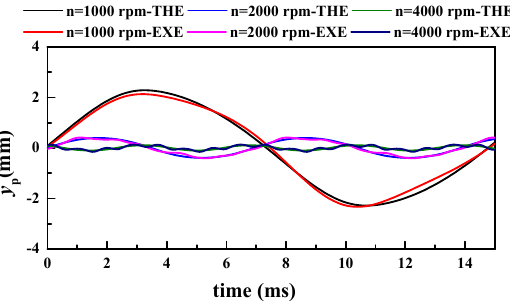
Figure 41. Vibration waveforms of different oil supply pressures (MSE 4MPa = 5.33 × 10 −4 , MSE 6MPa = 4.12 × 10 −4 , MSE 8MPa = 2.24 × 10 −4 ).